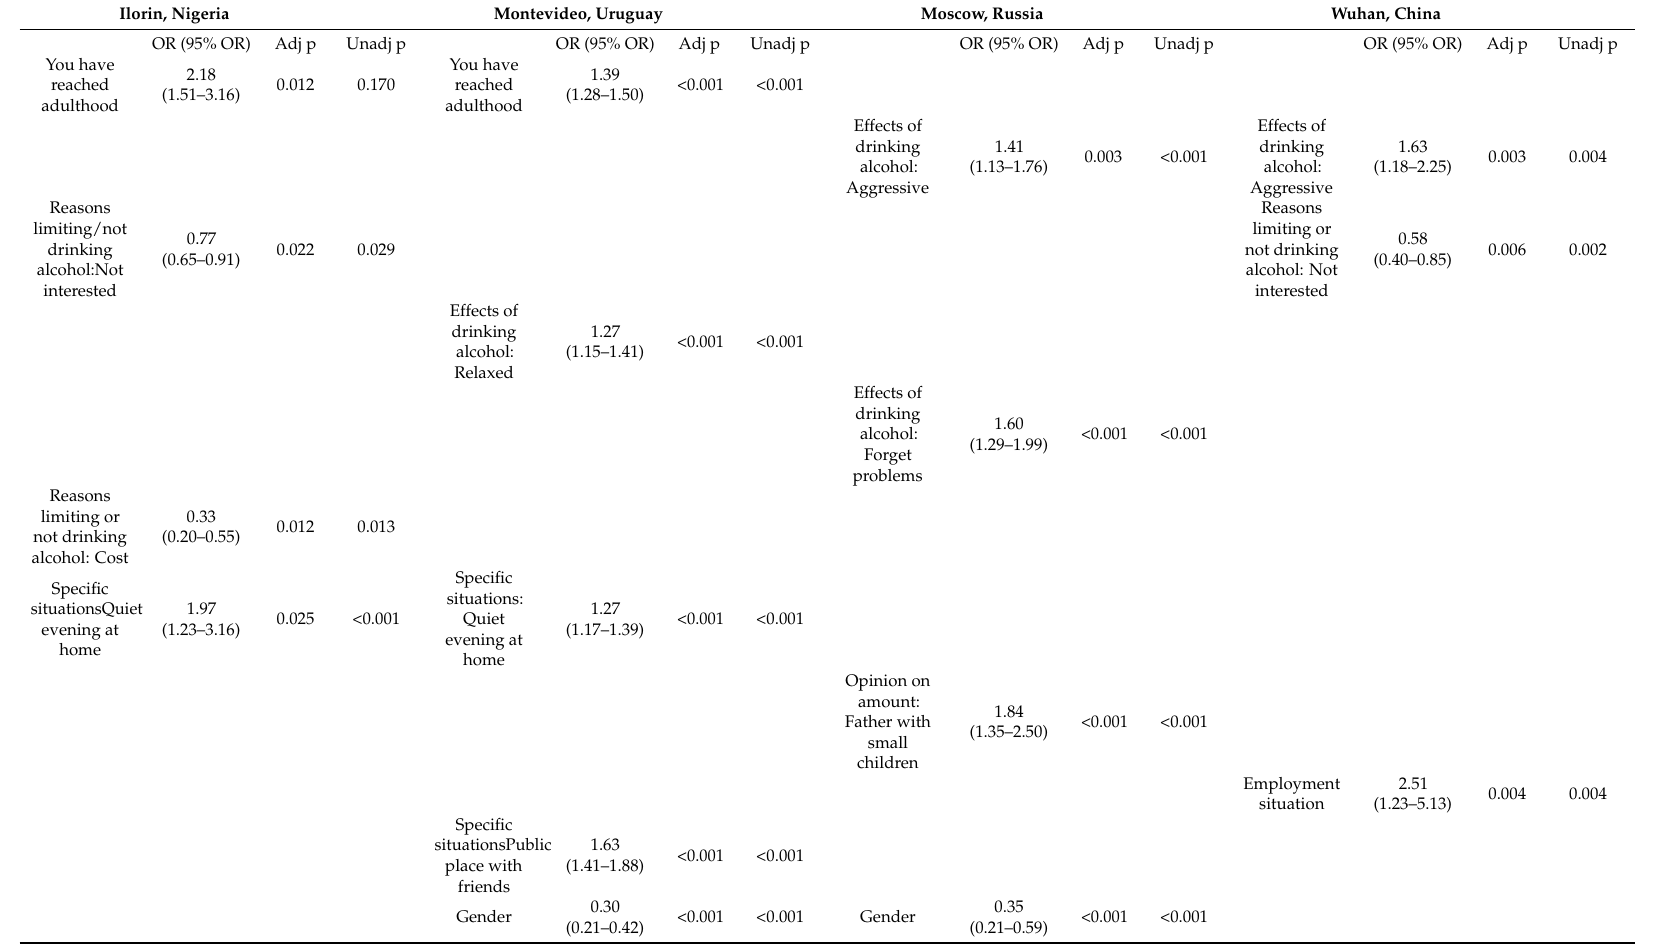
Table 4. The multivariable associations of heavy episodic drinkers by the city,